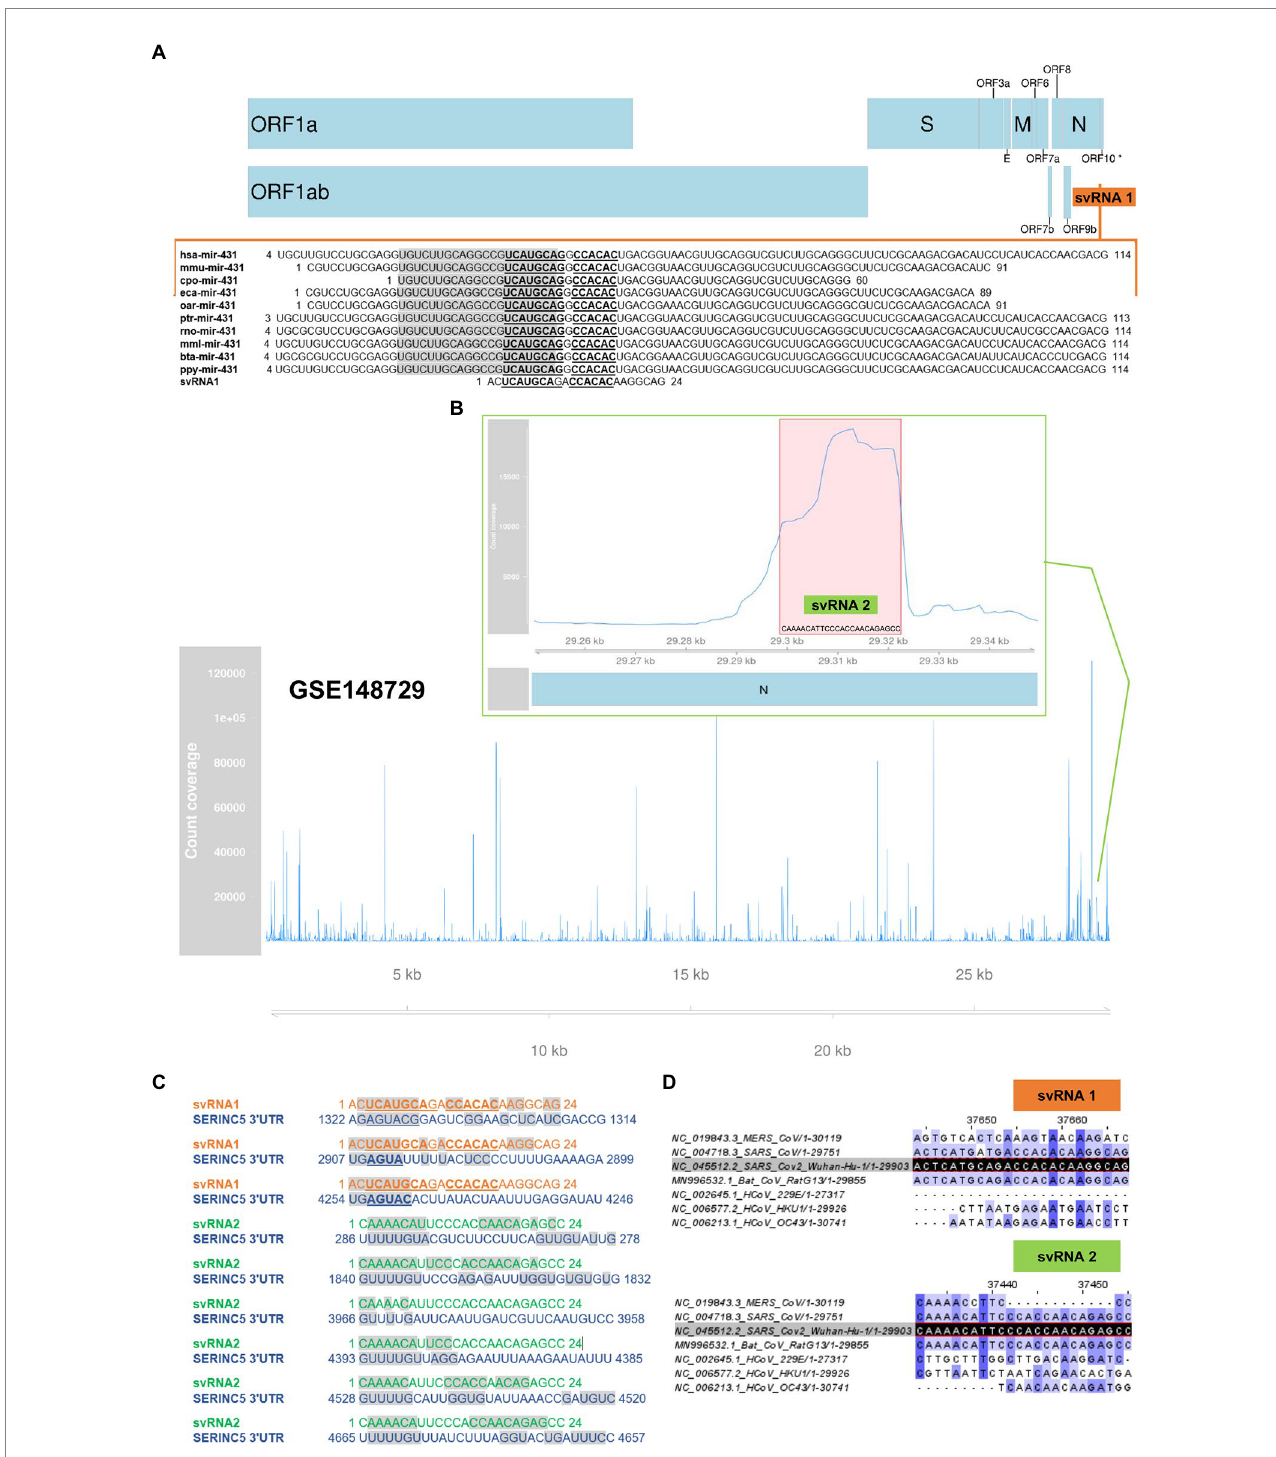
FIGURE 2 In silico prediction of SARS-CoV-2 svRNAs interacting with SERINC5 mRNA. (A) Identification of svRNA 1 using RNA Central Resources. Sequence and genomic location of svRNA 1 and alignment of svRNA 1 sequence with those of pre-miRNA-431 from different species are shown. The mature miRNA sequences are in grey shadow and the conserved nucleotides among species are in bold letters. (*) ORF10 has so far little experimental support as a protein-coding gene (B) Identification of svRNA 2 by reanalysis of GSE148729 dataset. Count coverage of small RNA sequences from SARS-CoV-2-infected Calu3 cells aligning with the SARS-CoV-2 genome is indicated. The top panel shows the region’s count coverage containing the svRNA 2 at 24 hpi. The red shadow indicates the svRNA 2 sequence. (C) Predicted interaction of svRNAs 1 and 2 with the 3’UTR of SERINC5 mRNA according to the Diana MR-microT tool. Grey shadow indicates nucleotides involved in the interaction. (D) Alignment of SARS-CoV-2 genome-encoded svRNA 1 and 2 sequences (dark shadow) with the genomes of other coronaviruses: